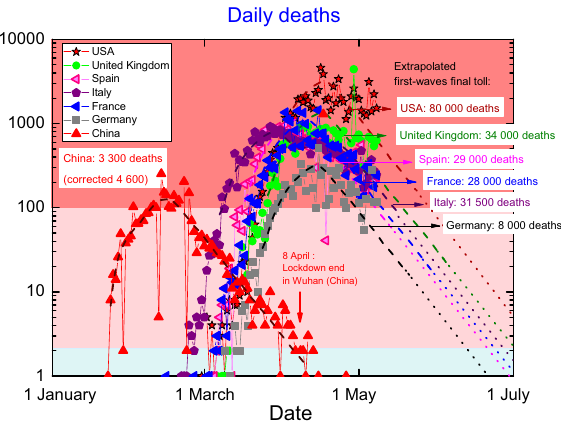
Figure 6. Fit to the daily death tolls as function of date in the assuming epidemic waves dynamics similar to that reported in